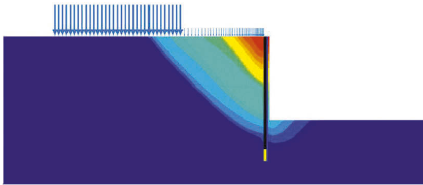
Figure 15: PLAXIS output global stability.